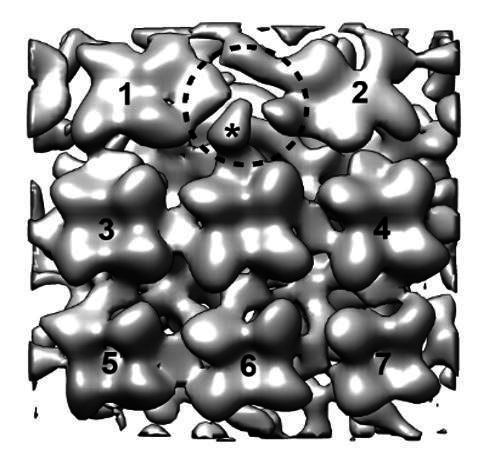
A reconstruction of a hantaviral spike using particles manually picked from “break points” in the lattice.The resulting map displays an empty patch of membrane where an 8th neighbour would normally be expected as indicated with a dashed circle. Additional density that likely corresponds to fab P-4G2 is indicated with an asterisk. This reconstruction is generated from 160 manually picked and aligned particles and displayed at a resolution of 50 Å for clarity.